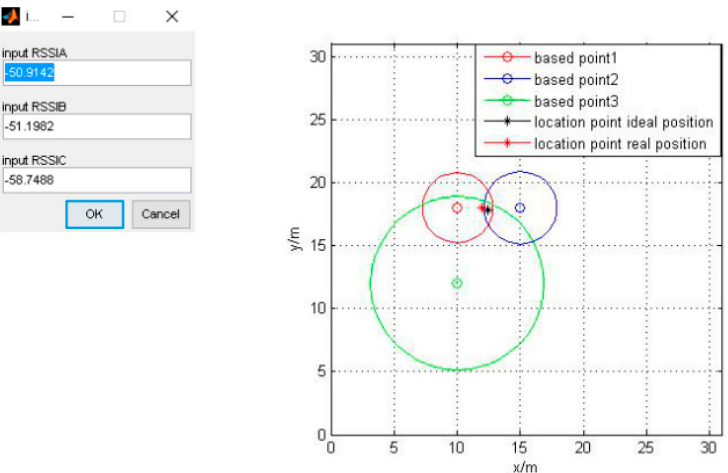
Figure 8. Simulation result when the RSSI values are − 50.9142, − 51.1982, and − 58.7488 (dBm) for the three points (a, b, and three points (a, b, and c).